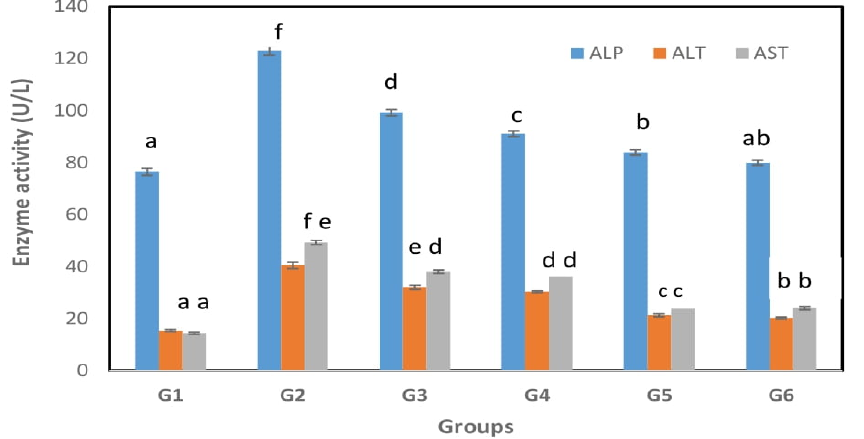
Figure 1. Effect of Spirulina maxima extract, Lactobacillus casei ATCC 7469-fermented wheat bran extract and their combination on liver function enzymes of Sprague–Dawley rats at 7 weeks. G1: Regular diet (R.D.); G2: High-fat diet (HFD); G3: Spirulina maxima extract G4: HFD+ Lactobacillus casei ATCC 7469-fermented wheat bran extract; G5: HFD+ combination of Spirulina maxima extract and Lactobacillus casei ATCC 7469-fermented wheat bran extract; G6: HFD+ rosuvastatin. The results are expressed as the means ± SD ( n = 5). Bars with different superscripts are significantly different ( p < 0.05).